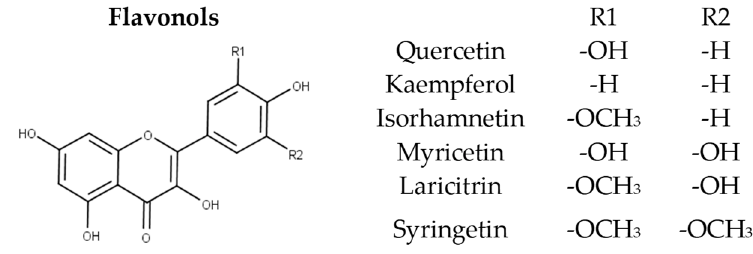
Figure 5. Structure of the six main flavonol aglycons.